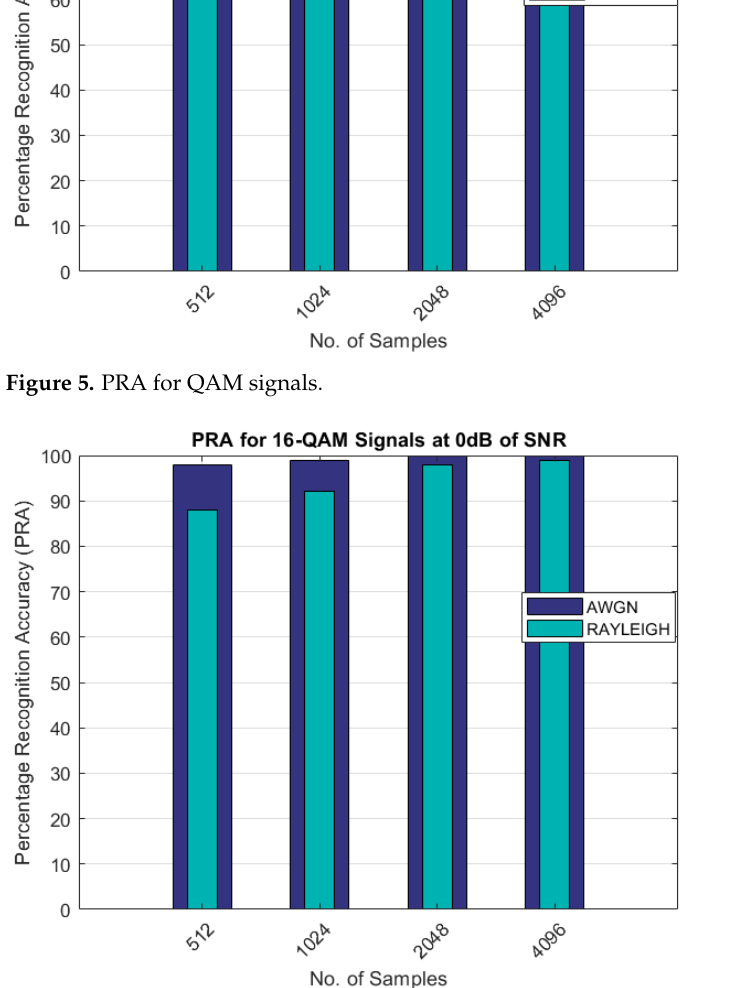
Figure 6. PRA for 16-QAM